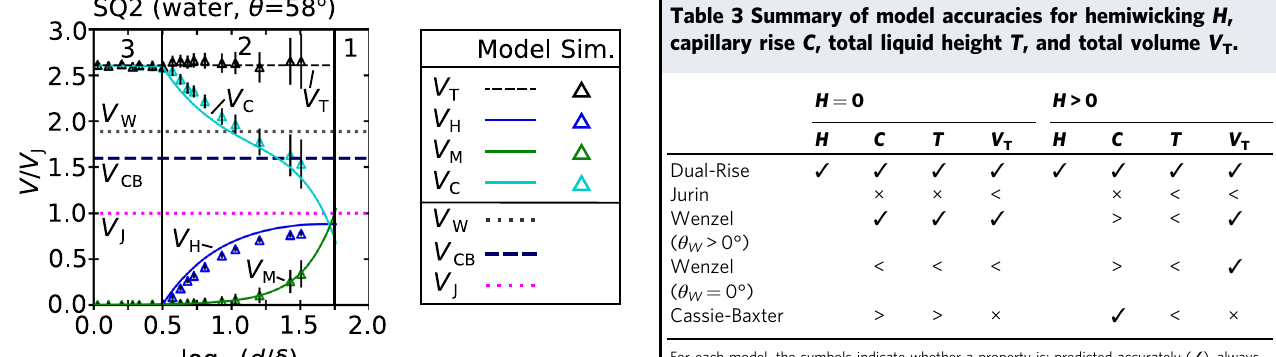
For each model, the symbols indicate whether a property is: predicted accurately ( ✓ ), always overestimated (>), always underestimated (<), inaccurate (×), or not predicted by the model (blank cell). θ W is the Wenzel J , the